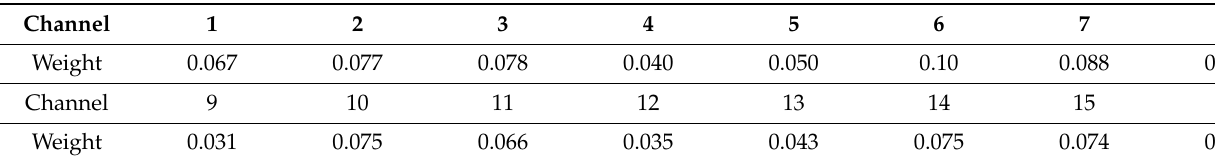
Figure 6. Sound field distribution of the centrifugal pump.